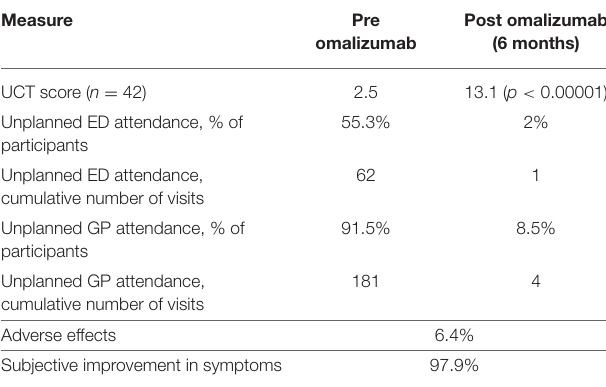
TABLE 2 | Pre and post omalizumab